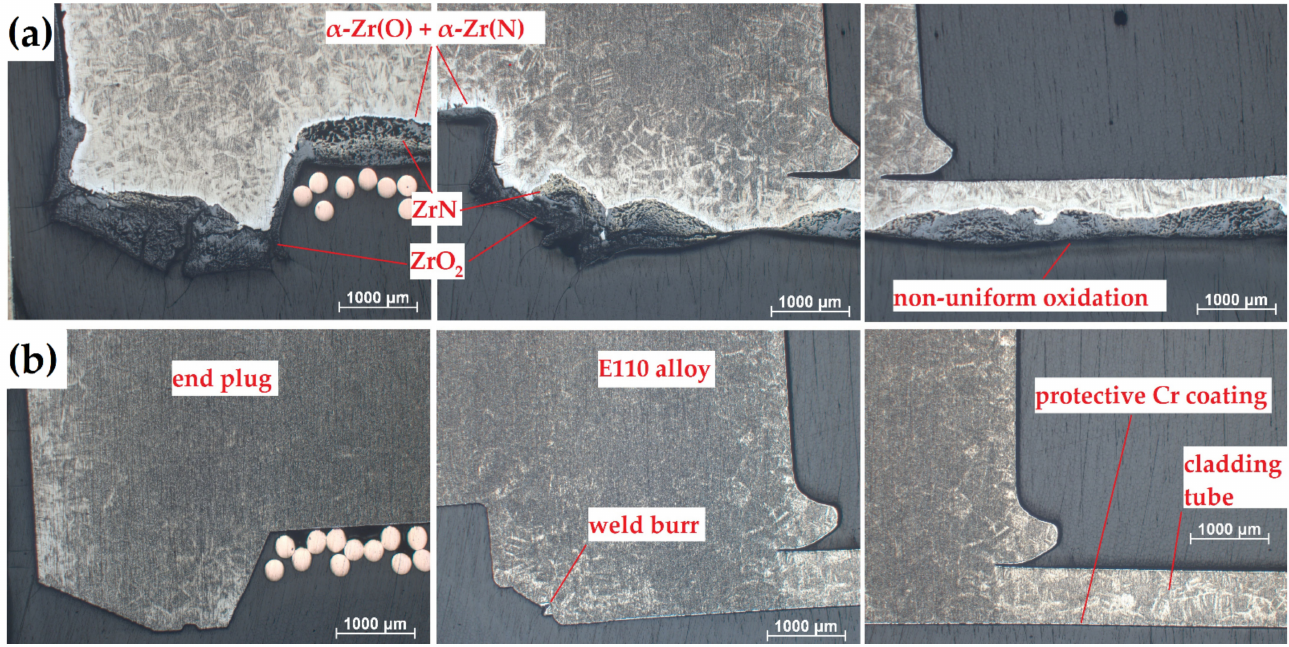
Figure 5. Optical images of cross-section microstructures of ( a ) uncoated and ( b ) Cr-coated samples after oxidation at 1100 ◦ C for 30